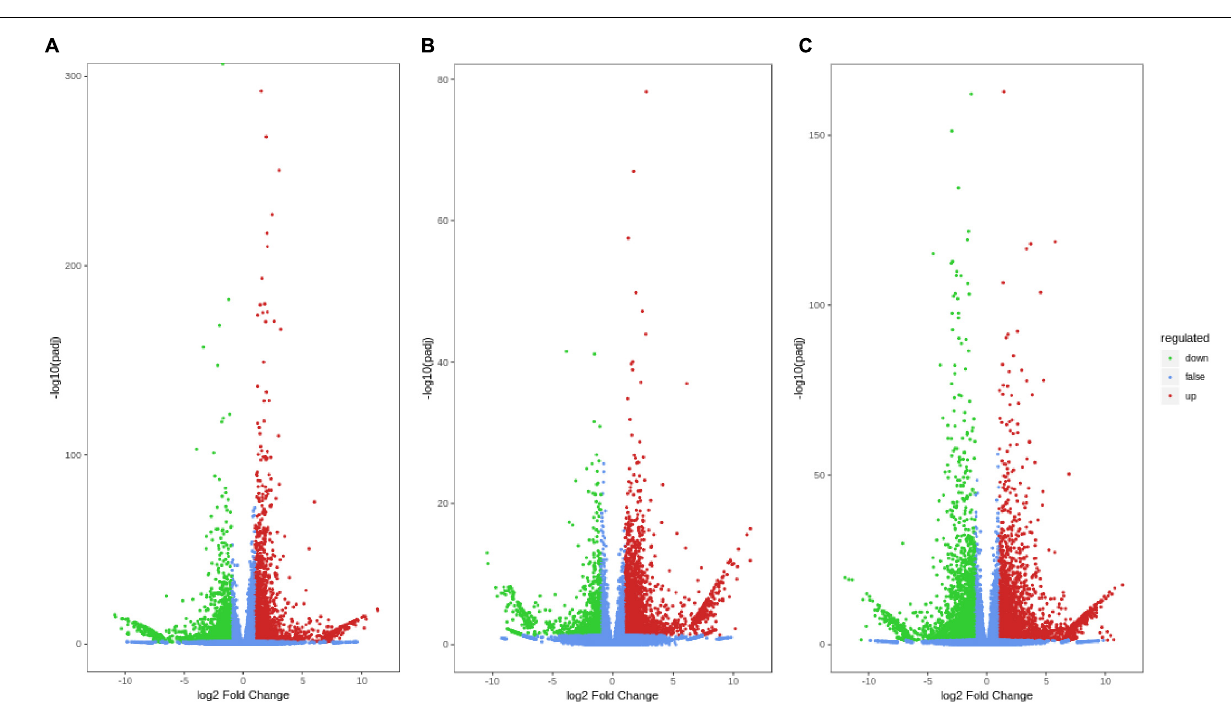
the top five significantly enriched pathways for A-J vs. B-J ( Figure 4 ). The top five terms for A-L vs. B-L were metabolic pathway, biosynthesis of secondary metabolites,